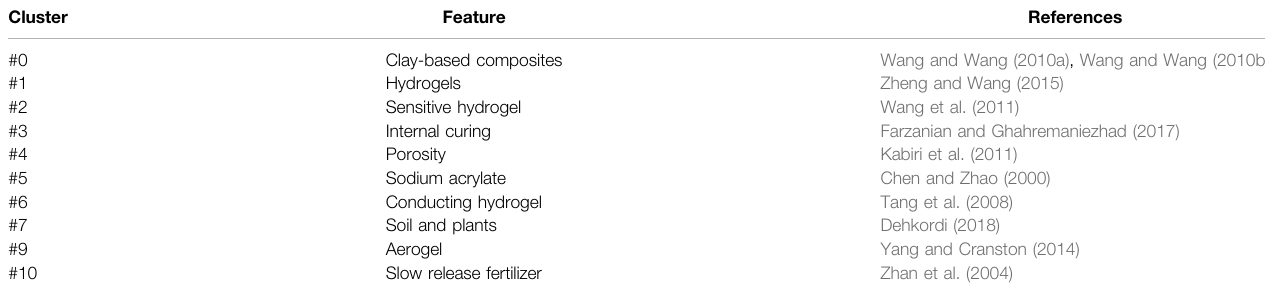
TABLE 6 | Ten representative frontier works in the ten biggest clusters.